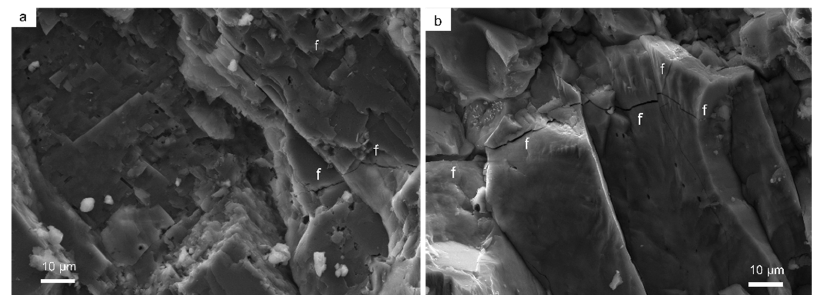
Figure 7. SEM images showing fissures (f) for samples heated to 400 °C ( a ) and 600 °C ( b ) and then water ‐ cooled. An increase of 2000× was used for all figures.